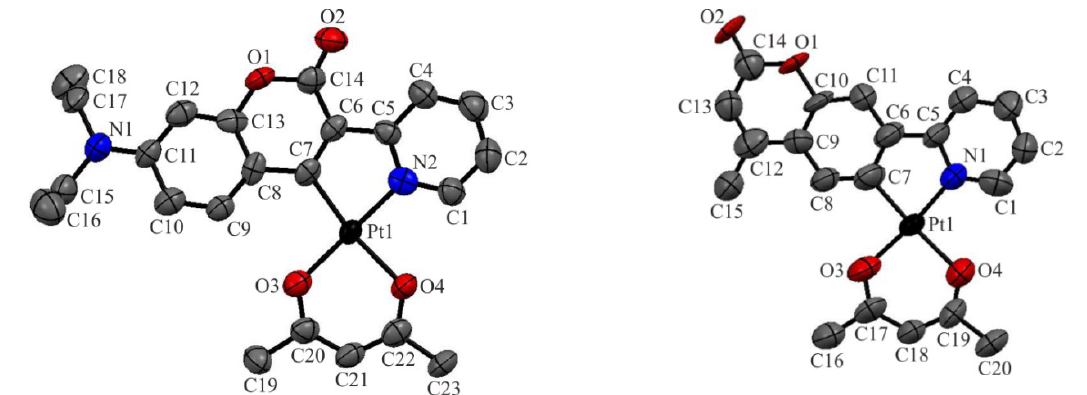
Figure 1. Structures of complexes 1 ( left ) and 2 ( right ). Hydrogen atoms are omitted for reasons of clarity; ellipsoids are drawn at a 90% probability